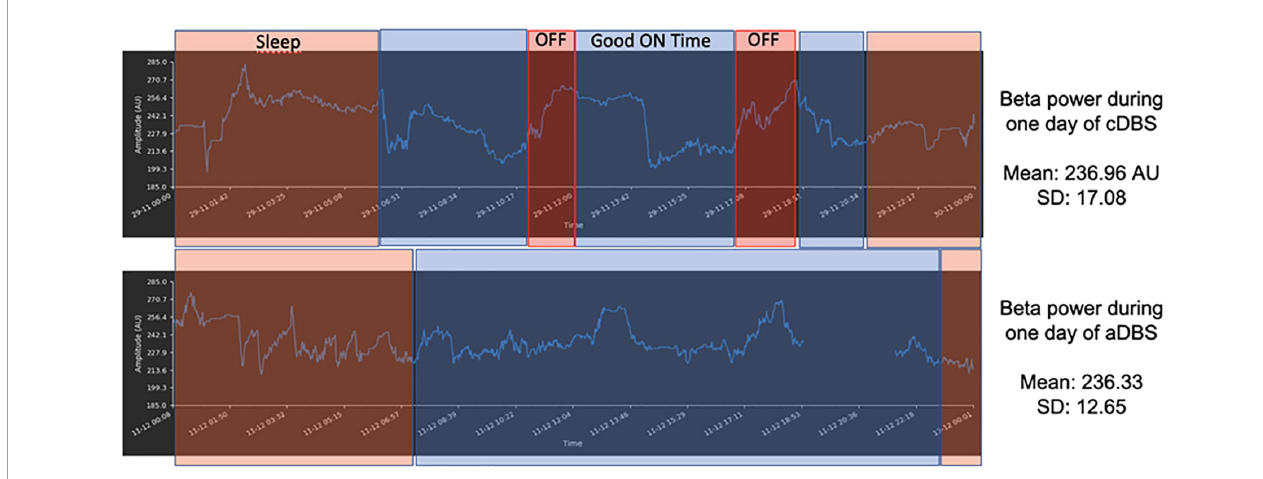
FIGURE5 Example of 1 day recording with matched diary features–Sleep–orange rectangles; OFF time–red rectangles; ON time without troublesome dyskinesias (Good on Time)–blue rectangles for AlphaDBS system in cDBS (top row) and aDBS (bottom row) . The x-axis is time (sampling frequency: 1 min) and the y-axis is beta power amplitude (arbitrary units–AU). The signal displayed was stored within the AlphaDBS IPG with the patient at home and was uploaded to the cloud system via telemetry and patient app, according to the data management protocol.